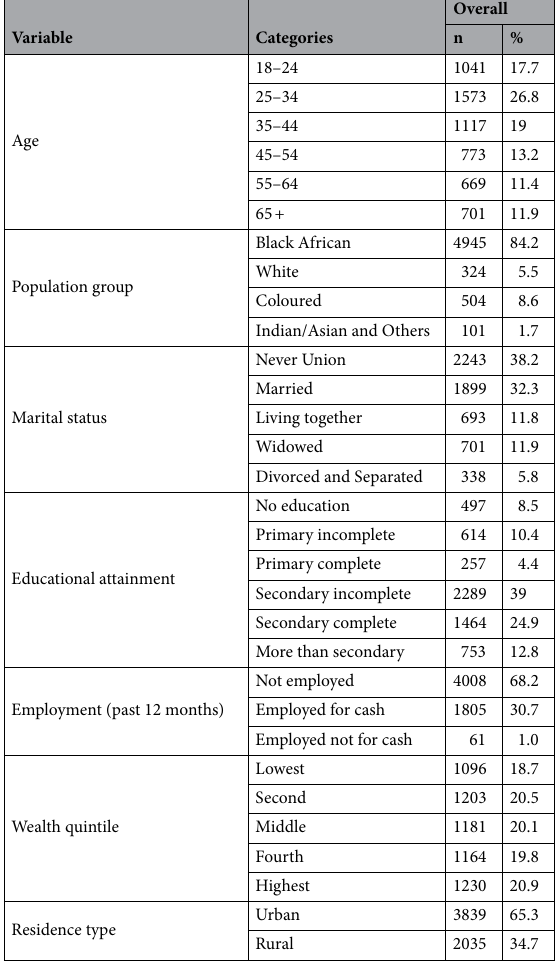
based on three measures, namely: RERI [Relative excess risk due to interaction], AP [attributable proportion] and S [Synergy index] and their 95% confidence intervals using the delta method 24,25 . RERI > 0, AP > 0 and S > 1 are indications of interactions, with geographical clusters overlap of IPV, harmful alcohol use and HIV being referred to as ‘IPV syndemic’ in this investigation. Third, we undertook bivariate and multivariable logistic regression to identify significant Socio-demographic correlates of population-level IPV syndemics (residing in areas where all three health challenges overlap). The analyses were adjusted by Domestic Violence Module sur- vey weight provided by SA-DHS, with STATA 17 being used for analysis.